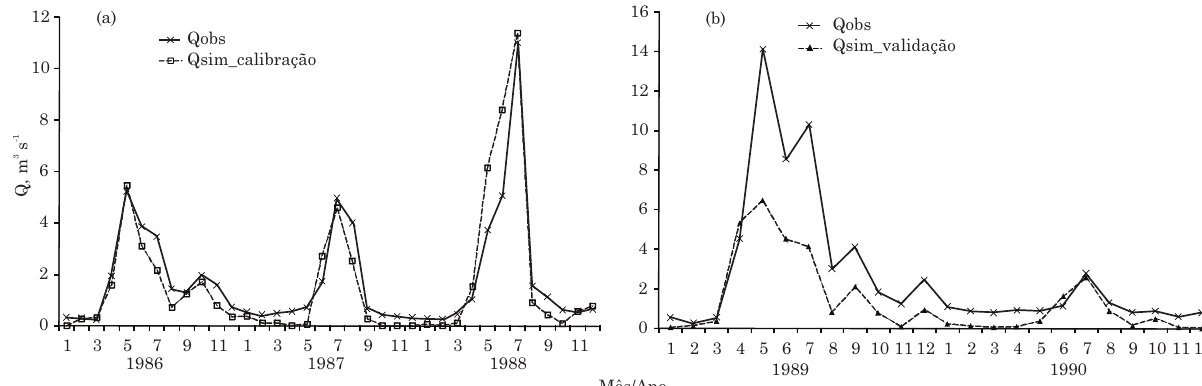
Figura 3. Hidrogramas observados (Qobs) e simulados (Qsim) para calibração (a) e validação (b), com dados do posto Fazenda Cajueiro (1986 a